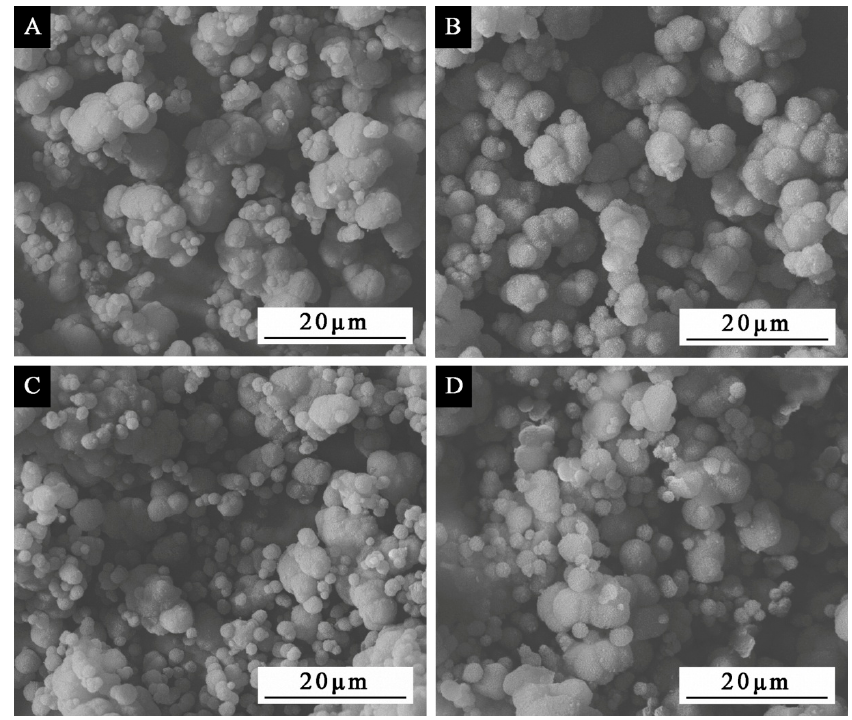
Figure 1. SEM morphologies of microcapsules by orthogonal experiment: samples 1–4# in Table 2.